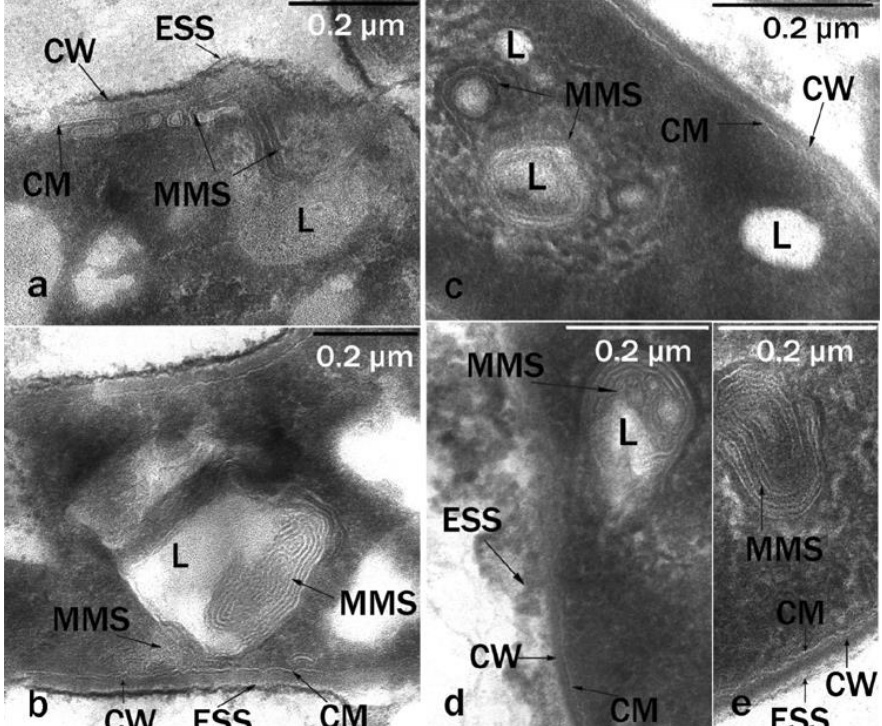
Figure 4. Ultrathin cell sections (cultivation conditions: solid hexadecane; 10 °C; 6 days): ( a , b ) — R. erythropolis S67; ( c , d , e ) — R. erythropolis X5. Intracytoplasmic membrane-like structures of various packaging are visible. CW, cell wall; MMS, multimembrane structures; CM, cytoplasmic membrane; L, lipid inclusions; ESS, extracellular surface structures; 0.2-micron scale. Near the surface and directly on the surface of the cells, multiple spherical structures with homogeneous contents were detected. These were vesicles (V) surrounded by a three-layer membrane (Figure 5). The outer surface of these formations was covered with a thin, loose layer with a high electron density. Electron-dense structures can appear as a result of the interaction of negatively charged succinoyl trehalolipids with positively charged ruthenium red. On ultrathin sections, electron-dense filaments (fibers, F) surrounded and connected the vesicles to the cell surface. These fibers were hollow pili-like structures (Figure 5, on the right).